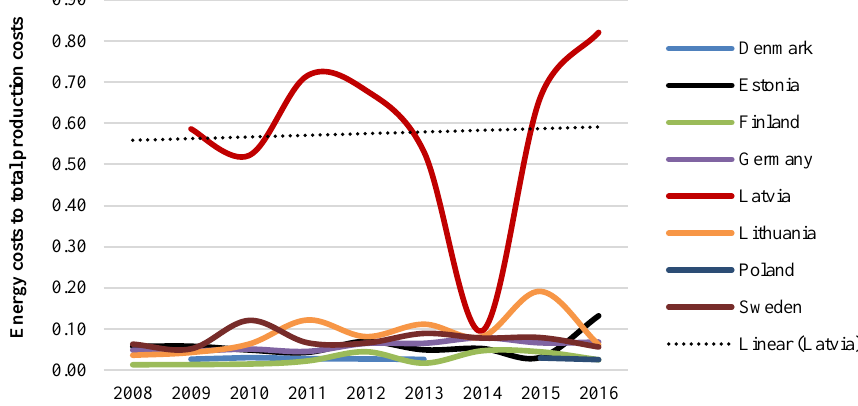
Fig. 5 . Energy costs to total production costs in manufacture of other products of wood; manufacture of articles of cork, straw and plaiting materials (NACE 1629) (Latvia and Baltic Sea region countries). Authors conclude that further analyses of the wood and wood products sector which is the top high heterogeneity of the sector. Excluding the production of wood pellets, the rest of wood